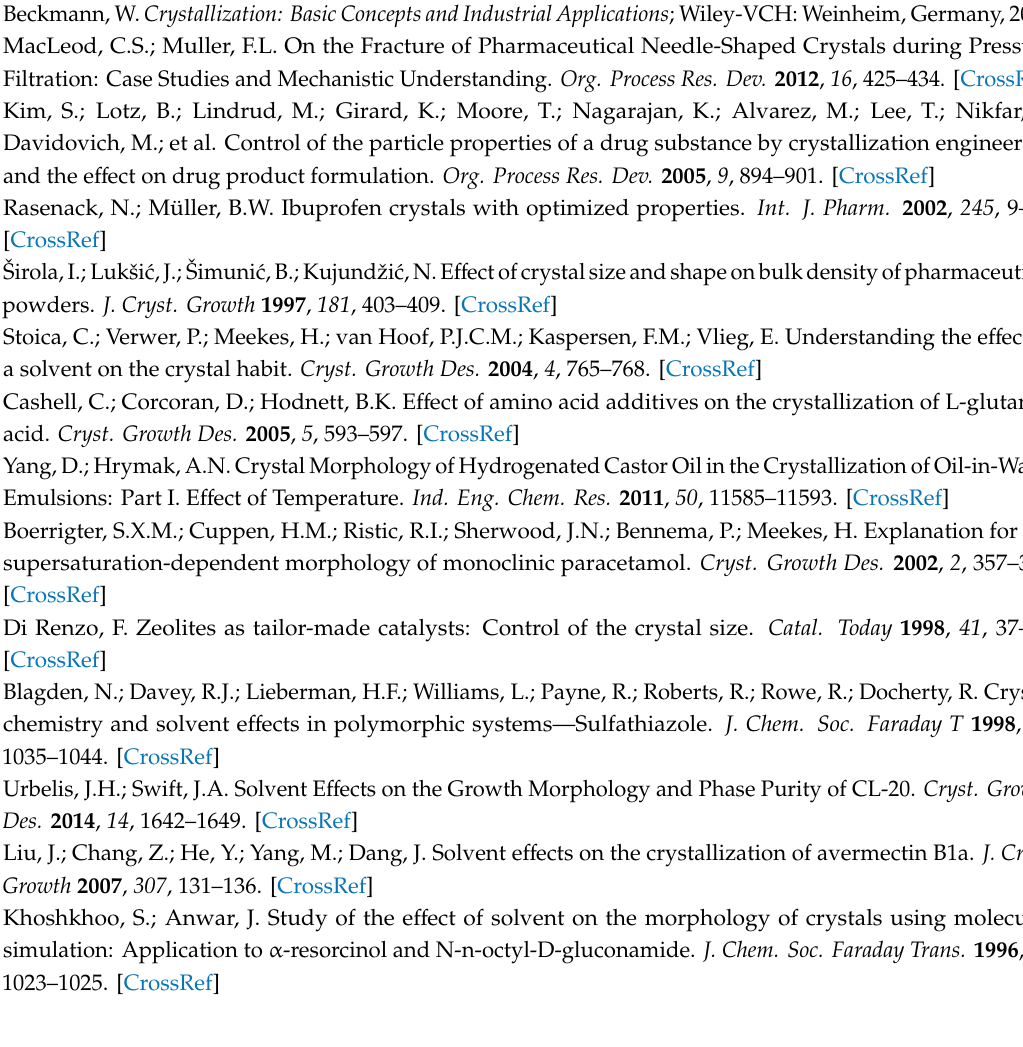
Table S1: The cleaved depth and size of catechol crystal faces to form a simulation supercell. Figure S1: The simulated XRD pattern of catechol crystal. Figure S2: The RDF analysis between catechol and methyl acetate on the (1 1 0)